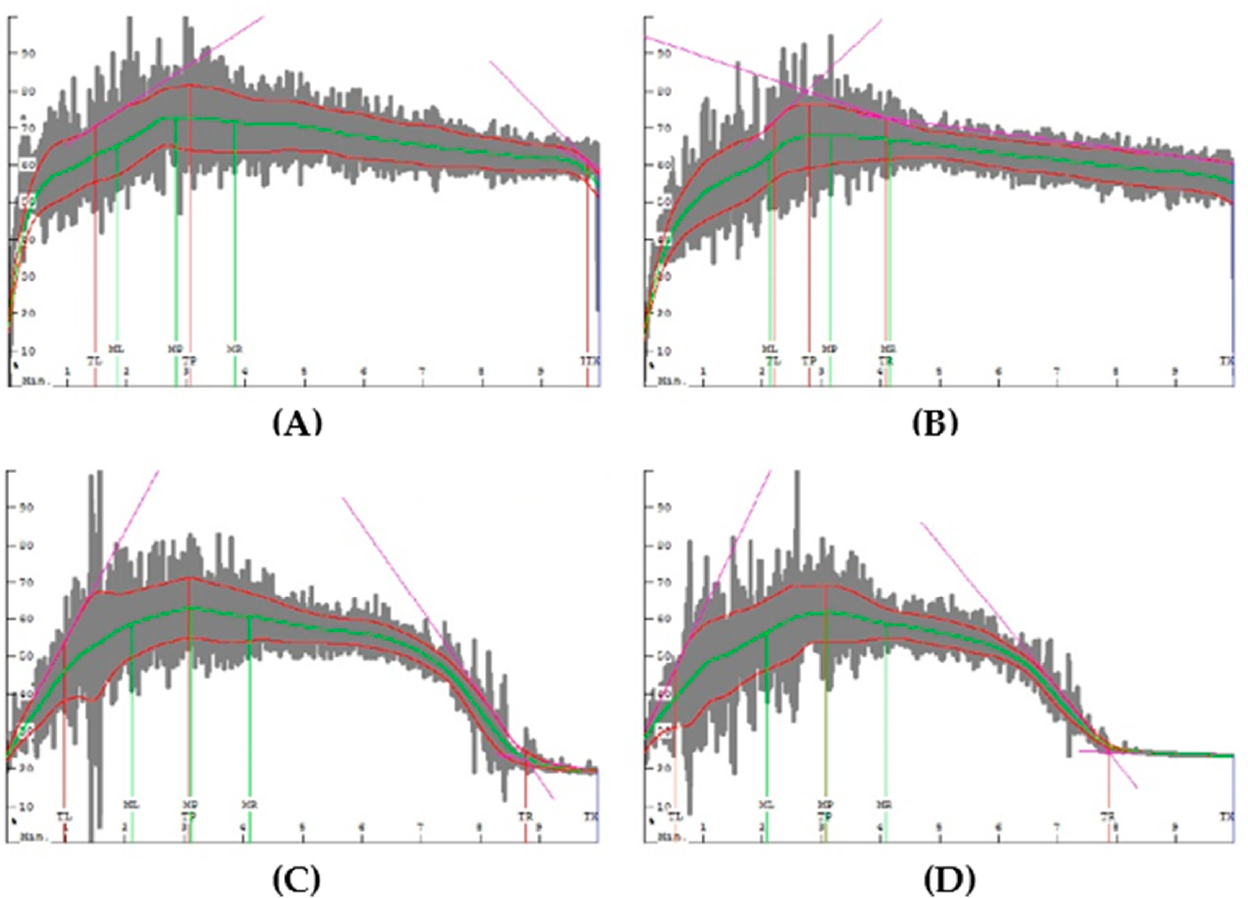
Figure 1. Mixograms of the flour–bran blends with different ratios: ( A ) F100/B0; ( B ) F90/B10; ( C ) F80/B20; ( D ) F70/B30. On the other hand, mixograms C (F80/B20) and D (F70/B30) of the flour–bran